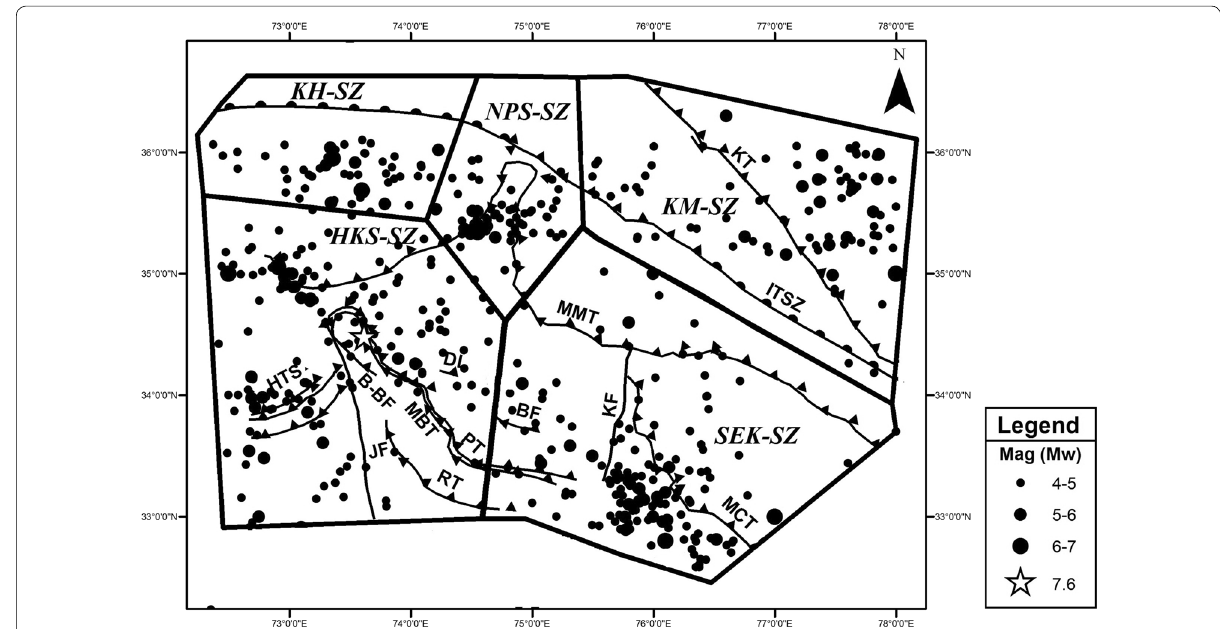
Fig. 2 The five seismic source zones considered for the probabilistic seismic hazard assessment of the Kashmir Basin: Hazara-Kashmir Syntaxis Seismic Zone (HKS-SZ), Nanga Parbat Syntaxis Seismic Zone (NPS-SZ), SE Kashmir-Seismic Zone (SEK-SZ), Kohistan Seismic Zone (KH-SZ) and Karakorum Seismic Zone (KM-SZ) after Sana and Nath (2017)